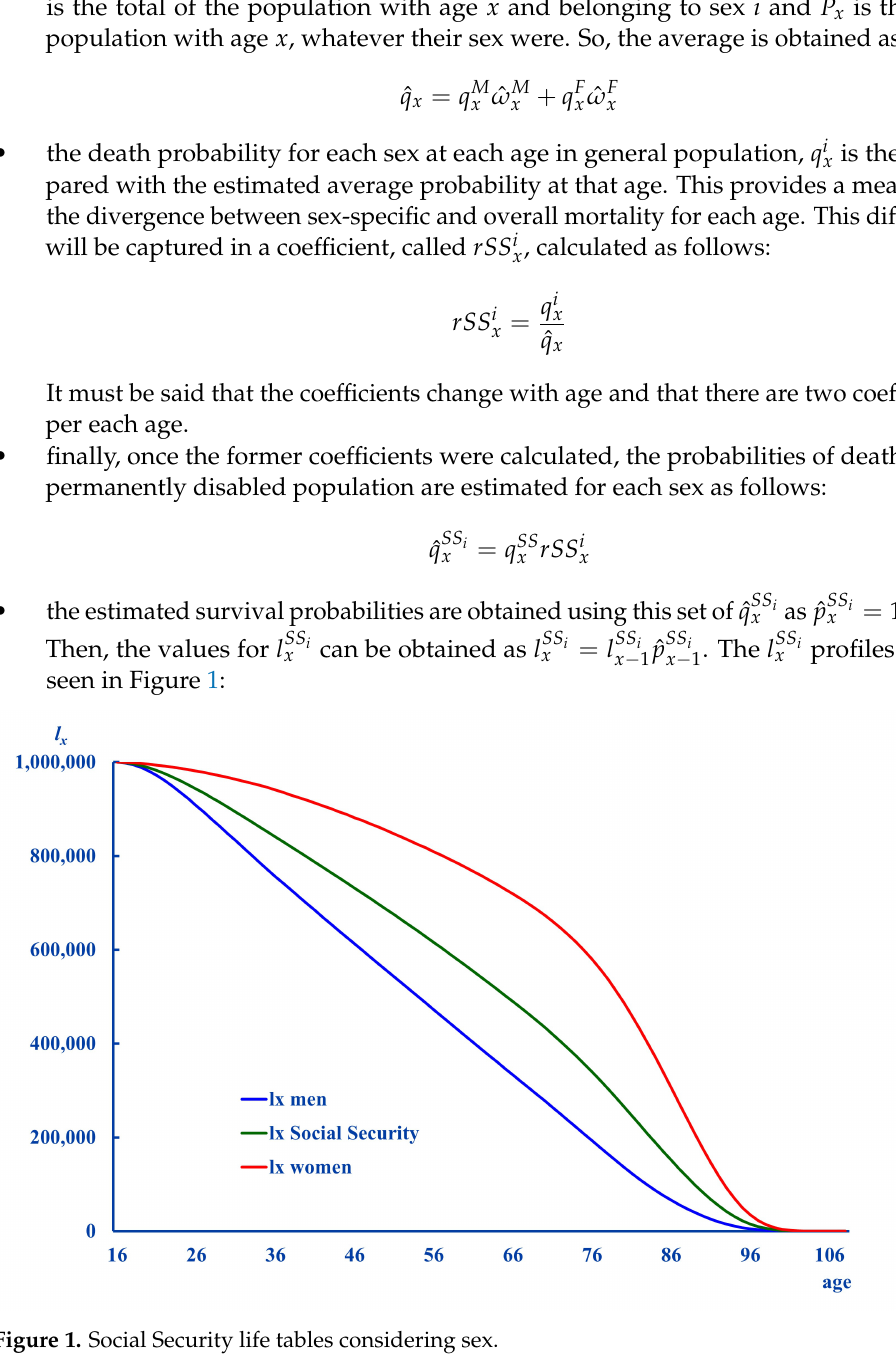
Figure 1. Social Security life tables considering